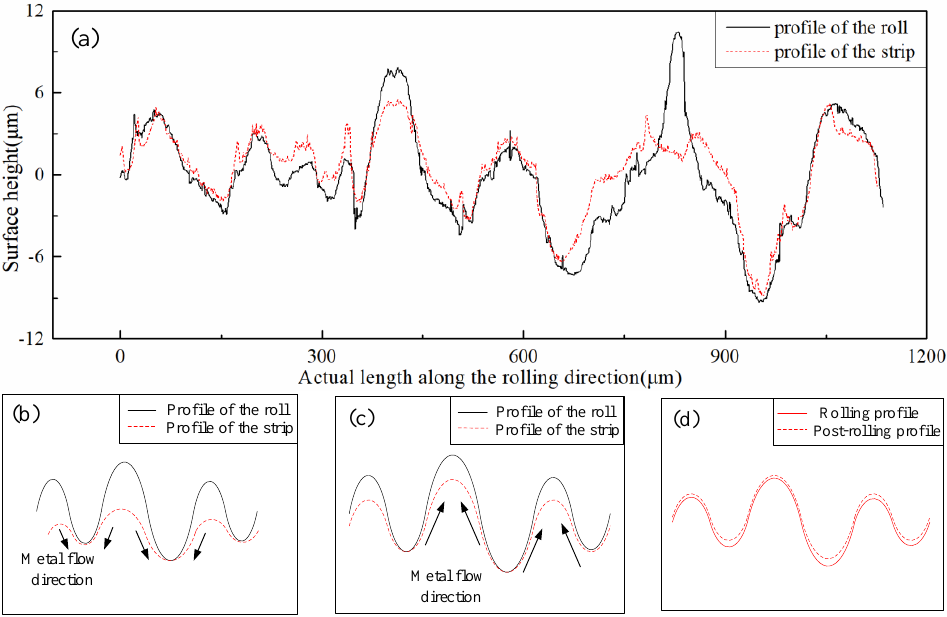
Figure 9. Mechanism of strip surface topography during the rolling process: ( a ) profile of roll and strip along the rolling direction, ( b ) initial press-in process, ( c ) strip filling process and ( d ) strip elastic recovery.